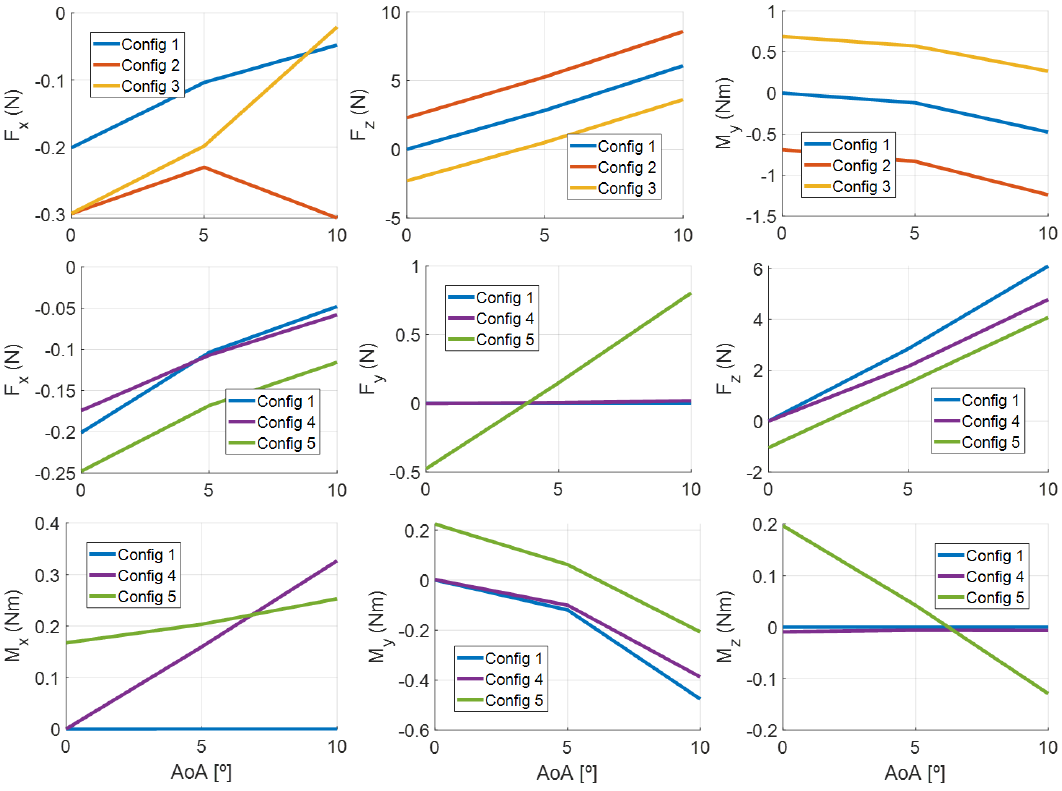
Figure 11. Forces and moments acting over the body frame for the five poses indicated in Table 2, compared to the flat configuration: tail actuation ( first row ), elbow, and shoulder rotations ( second and third rows ).